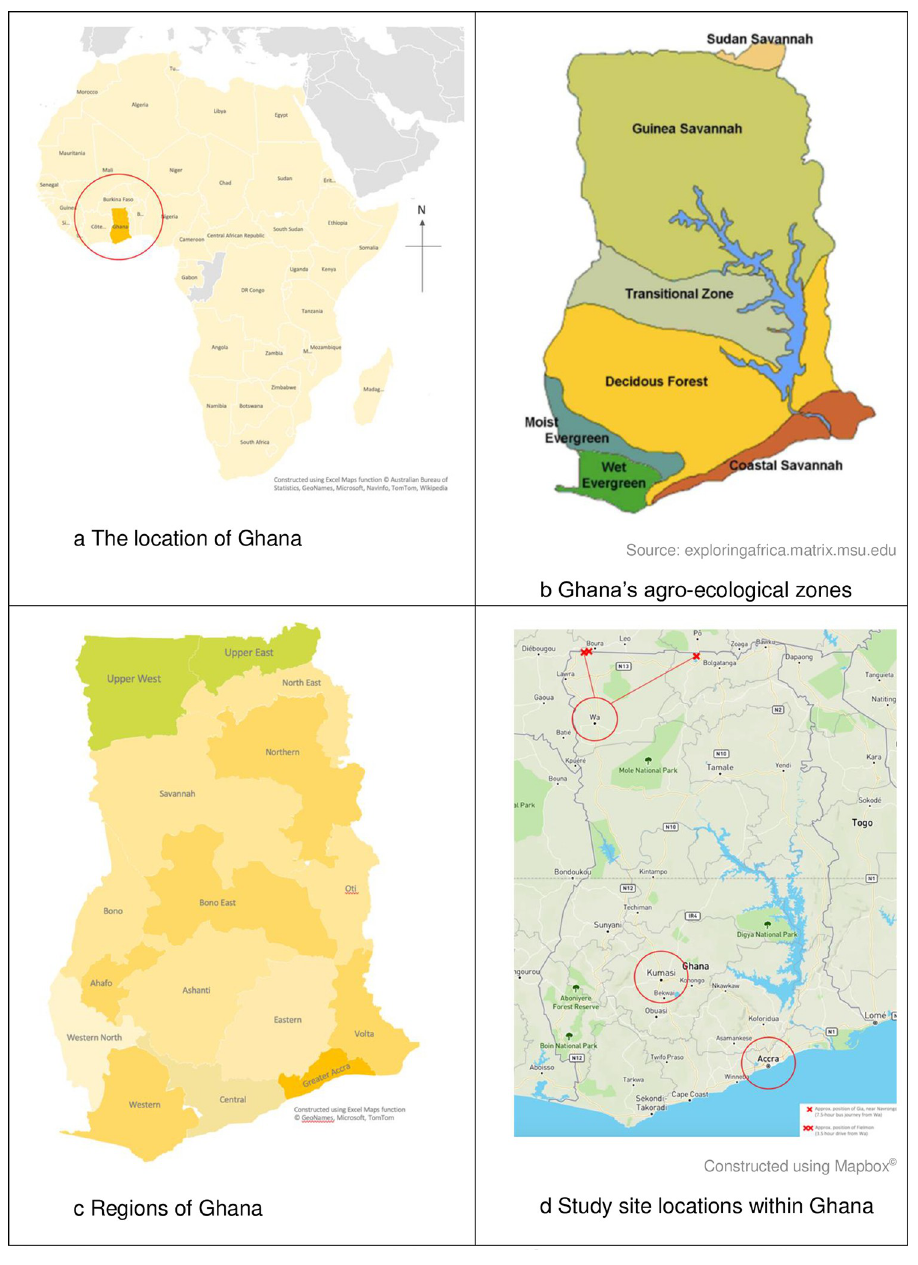
Fig 3. The research environment of this study. Source: Maggs, 2022